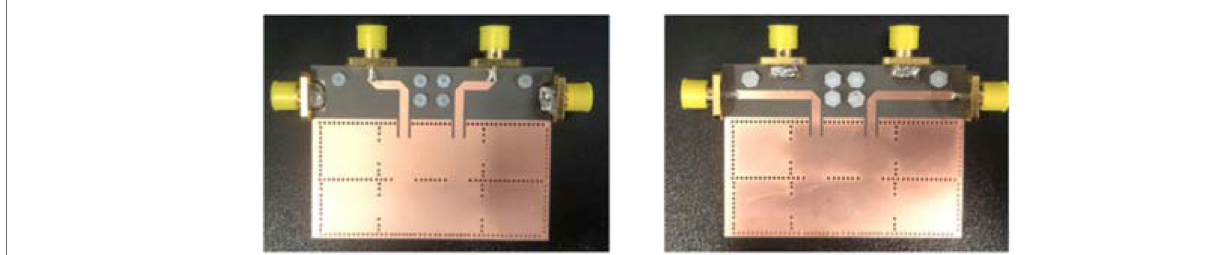
FIGURE 4 | The photograph of the fabricated circuit.